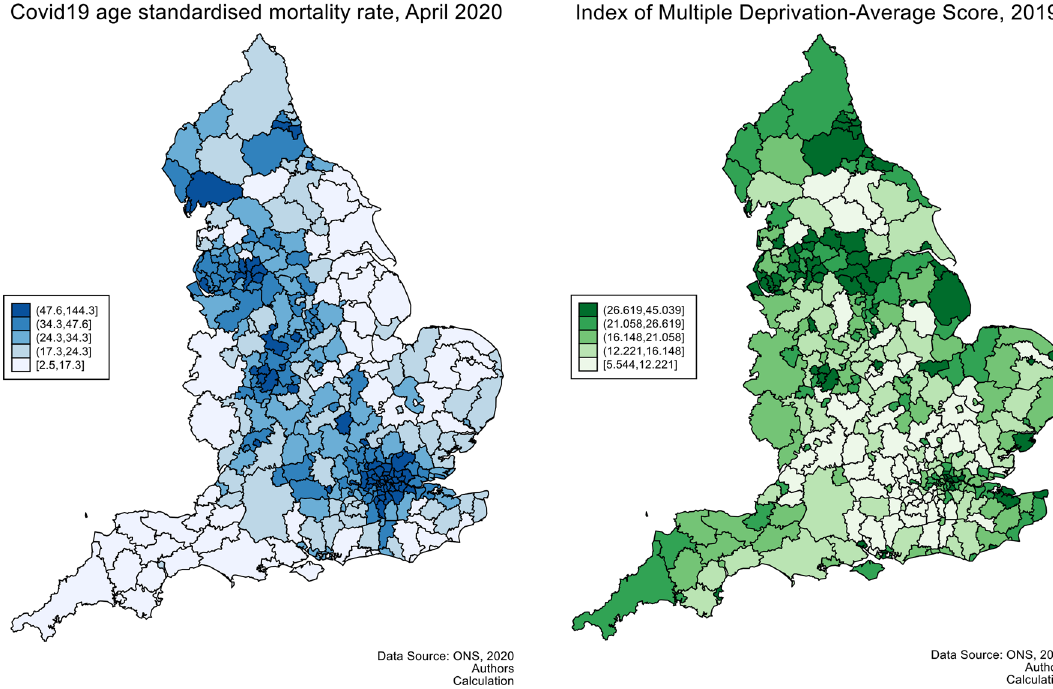
Figure 1. Age adjusted mortality rate and index of multiple